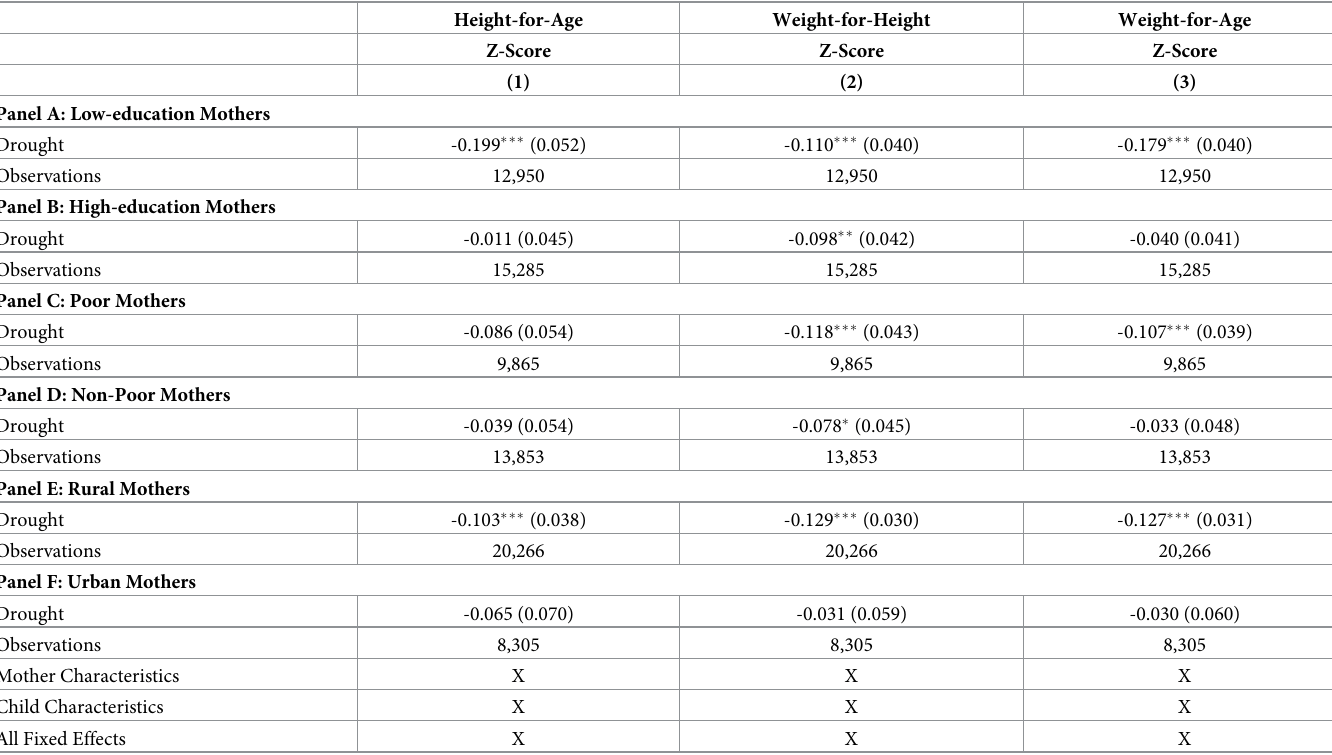
Table 3. Prenatal exposure to droughts and child health—Heterogeneity